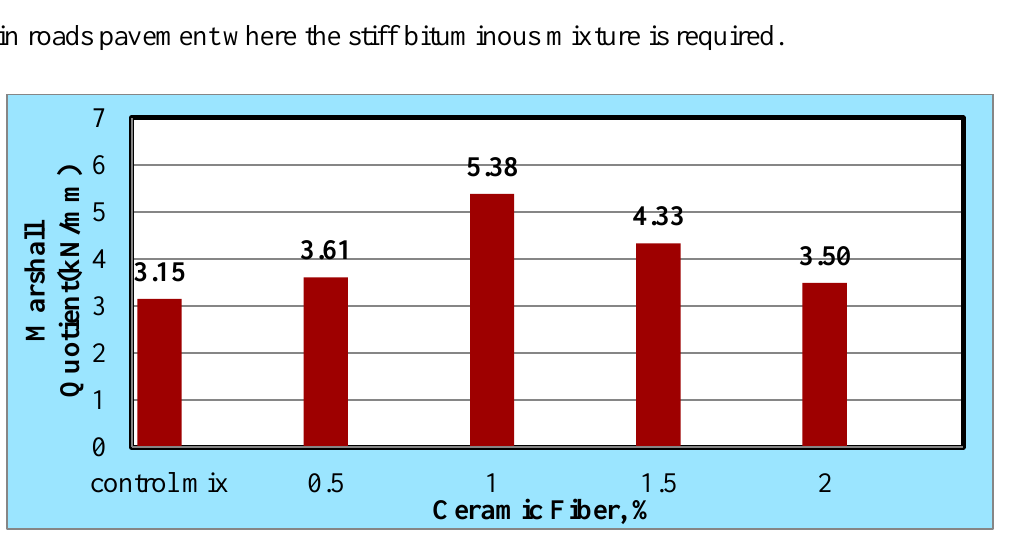
Fig. 3. Variation of Marshall Quotient with different Ceramic Fiber percentages,